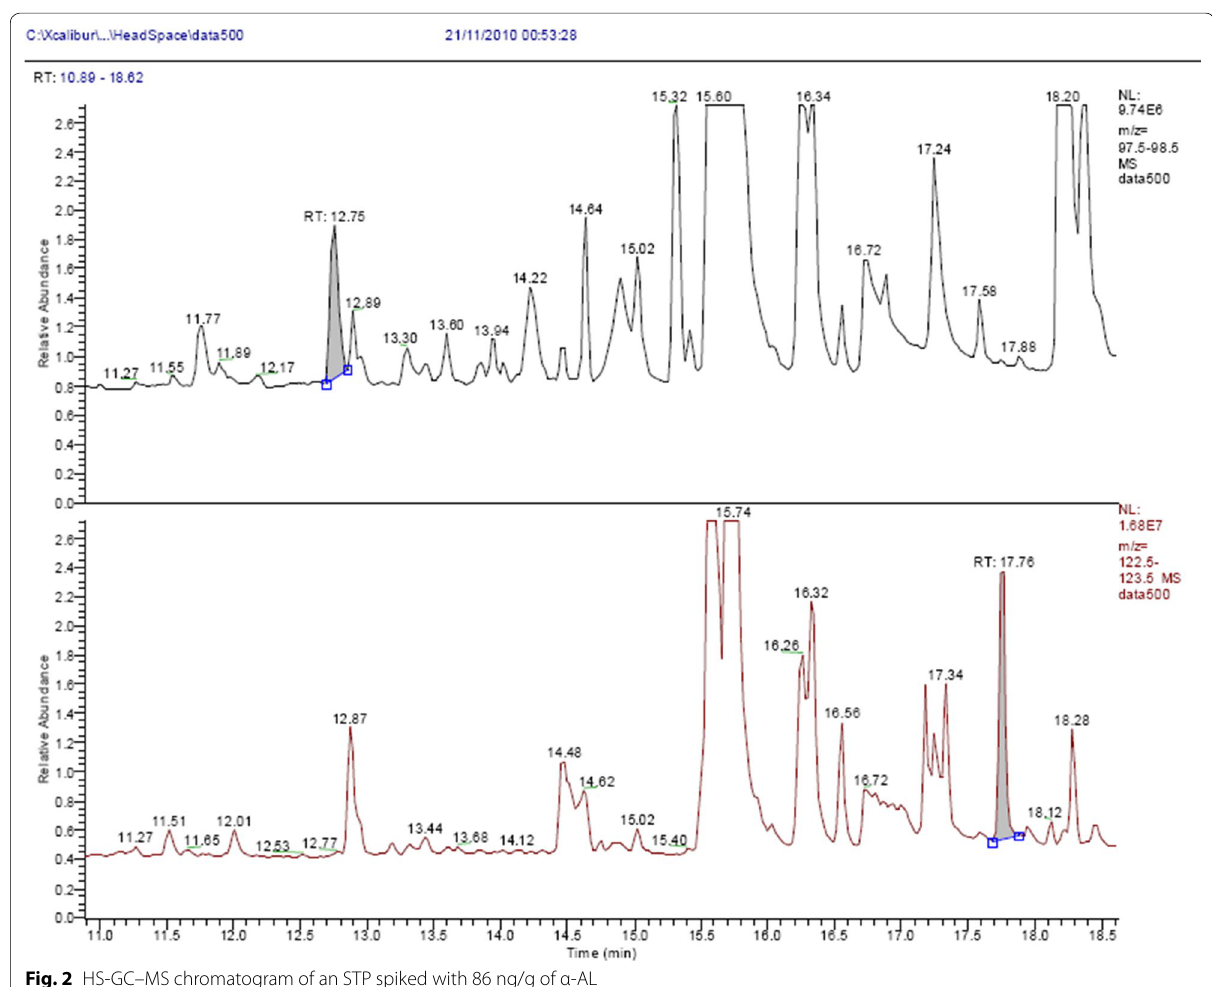
Fig. 2 HS-GC–MS chromatogram of an STP spiked with 86 ng/g of